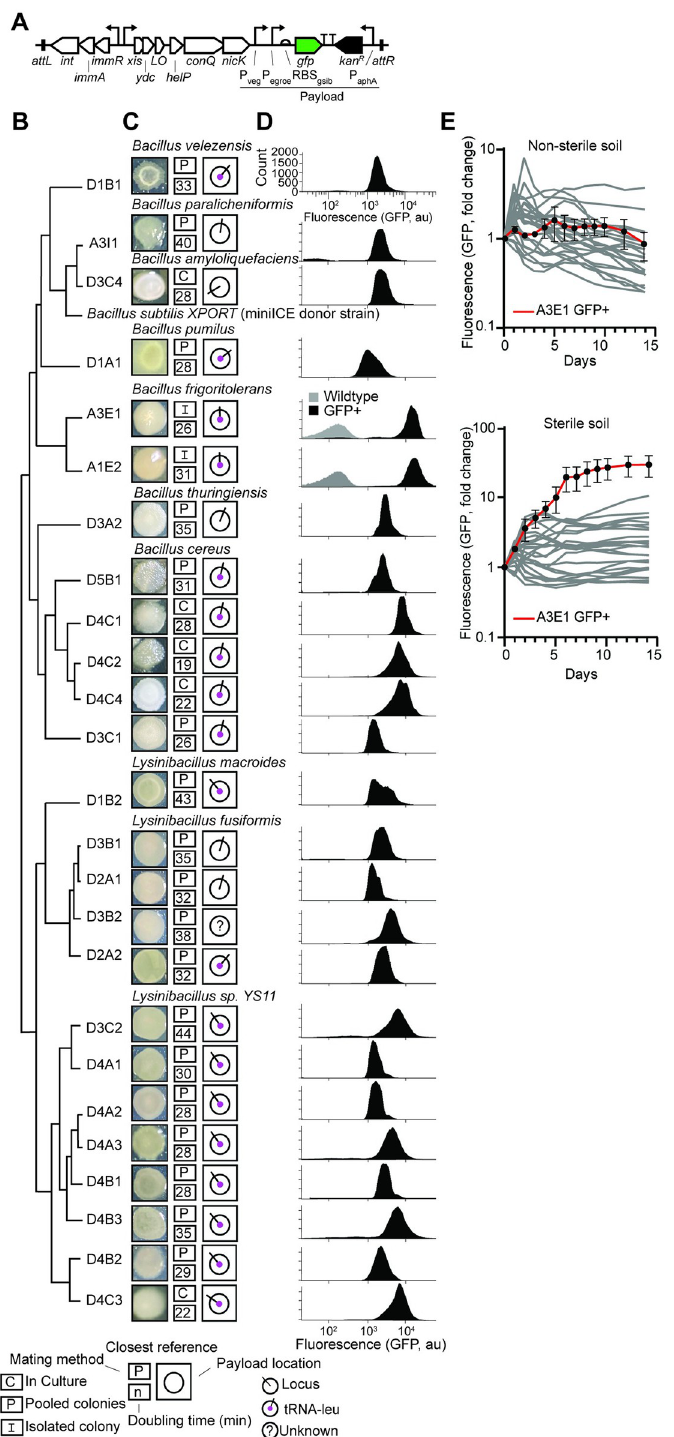
Fig 2. Rapid and parallel screening of engineered undomesticated bacteria from soil samples. (a) Genetic map of the mini-ICE Bs 1 cassette conjugated from the donor B . subtilis XPORT strain to recipient strains. (b) Phylogenetic tree based on 16S sequences (methods) describing the isolated and engineered undomesticated soil strains. Names of undomesticated isolates reflect the site and soil sample they were isolated from (e.g., D1B1 was isolated from site D1 in sample B1). (c) Characterization of colony morphology on agar (colony diameter in images ranges between 0.2–0.5